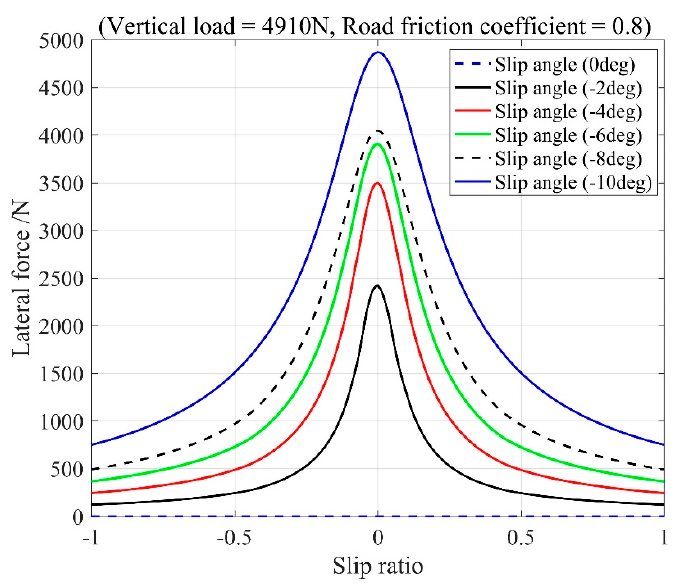
Figure 3. The tire lateral forces versus longitudinal slip and slip angle.